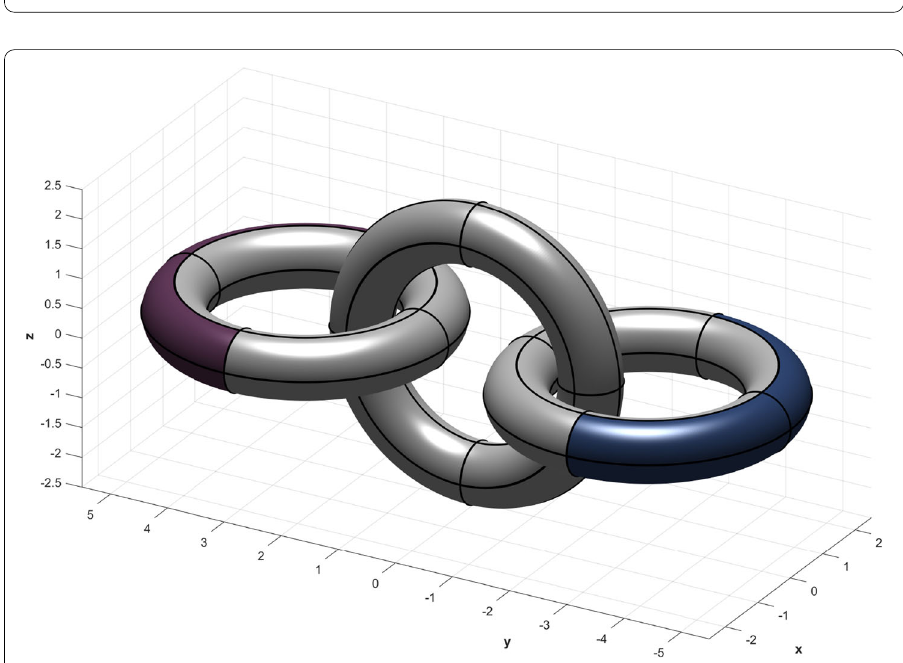
Fig. 16 Example 3. Small deformations contact between curved surfaces. A positive displacement along the y direction is imposed over the purple surfaces. All the DOFs are constrained over the blue surfaces